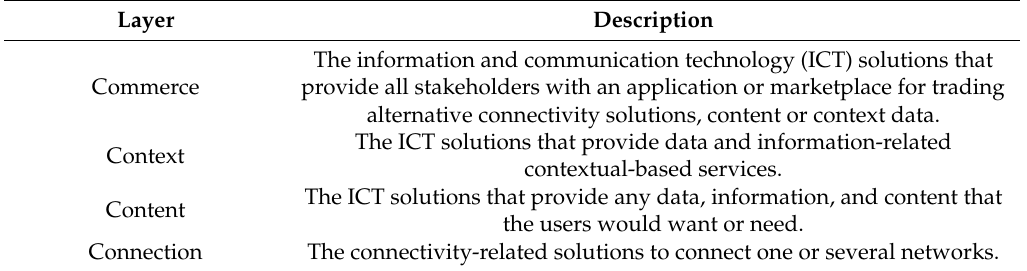
Table 1. The 4C framework for artificial intelligence (AI) energy platform (adapted from [69,85]).